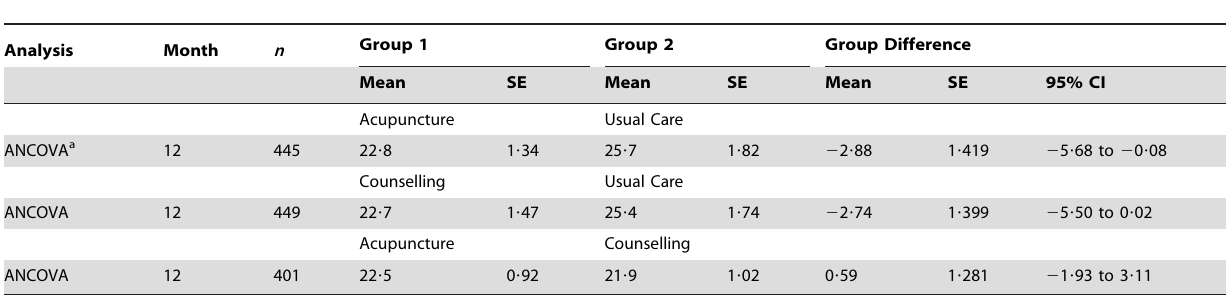
Table 4. Effect of trial arm on BDI-II depression.